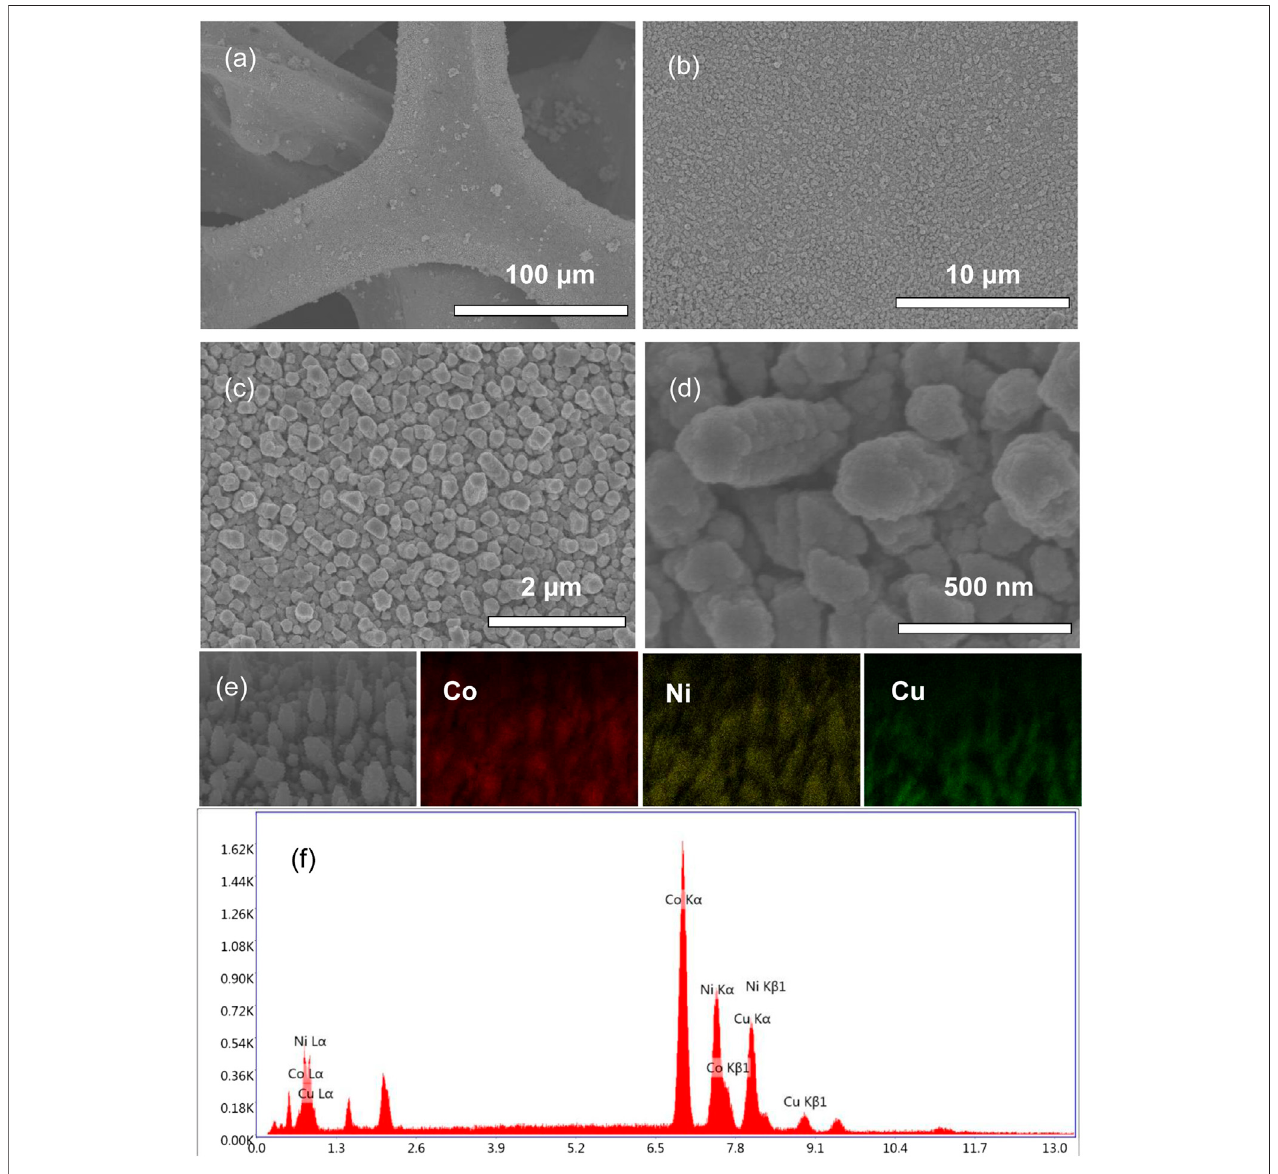
FIGURE 1 | SEM images at different magni fi cations (A – D) , elemental mapping (E) , and EDS pattern (F) of NiCo-1/CF.